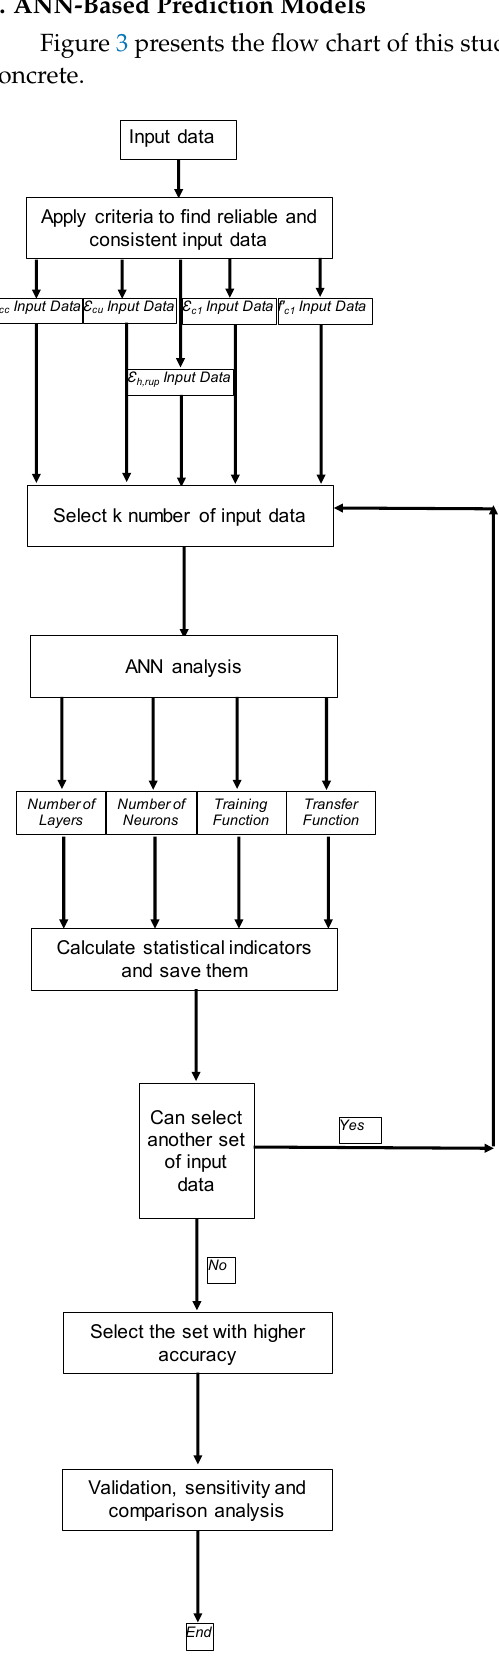
Figure 3. Flow chart of this study.